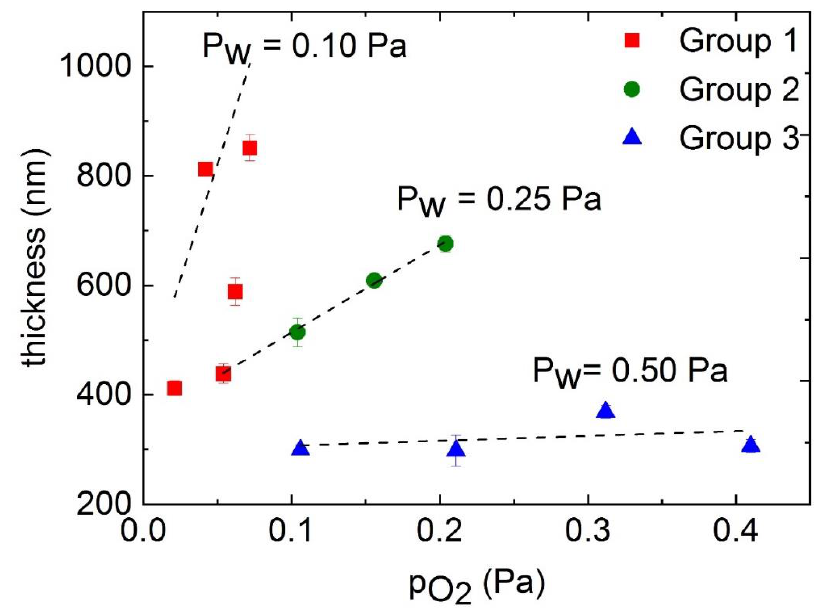
Figure 3. Coating thickness on silicon as a function of p O2 for samples belonging to group 1 (square, red), 2 (circle, green), and 3 (triangle, blue). A linear fit has been obtained for the samples deposited with the same working pressure. The total deposition time was 15 min in all cases.